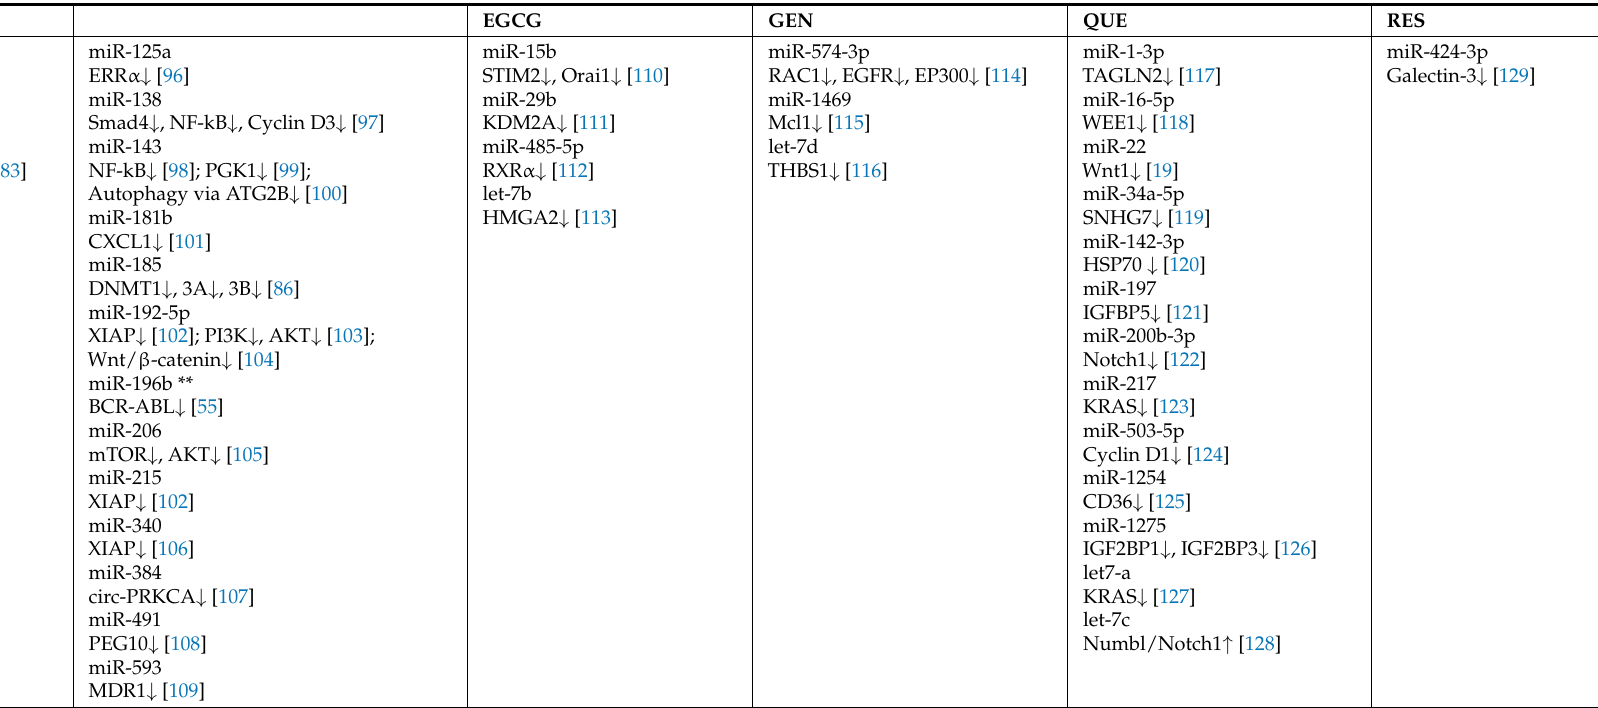
Table 3. miRs upregulated by one of five dietary polyphenols and their proposed targets